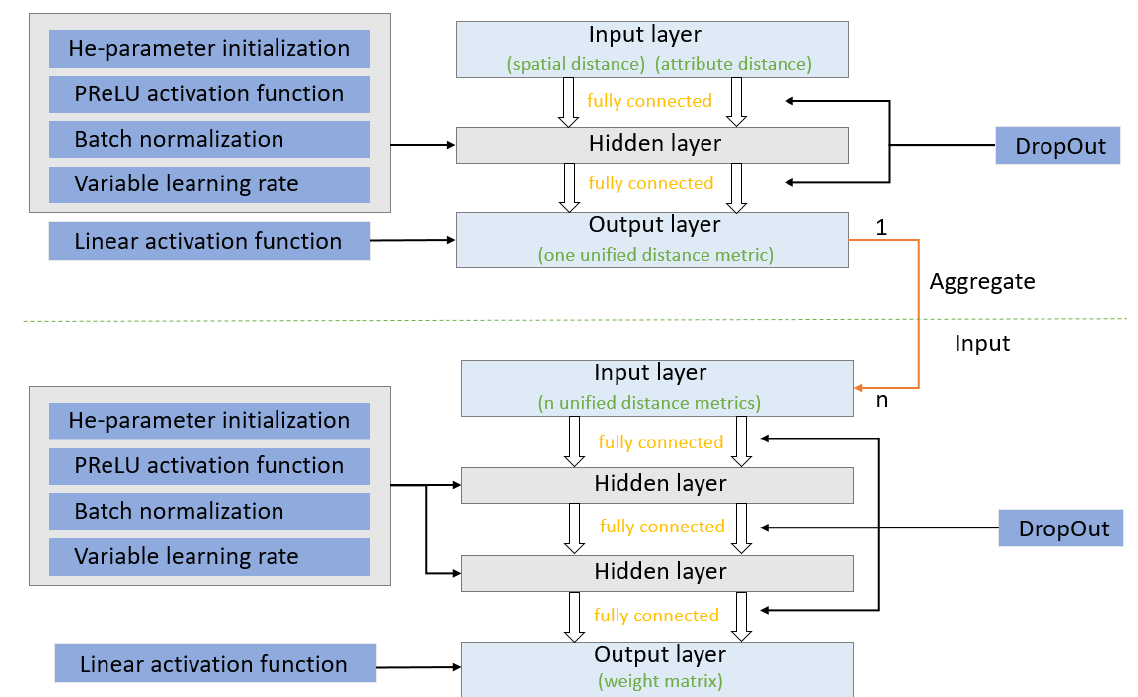
Figure 6. The training process of SANNWR. Table 3. The training process of